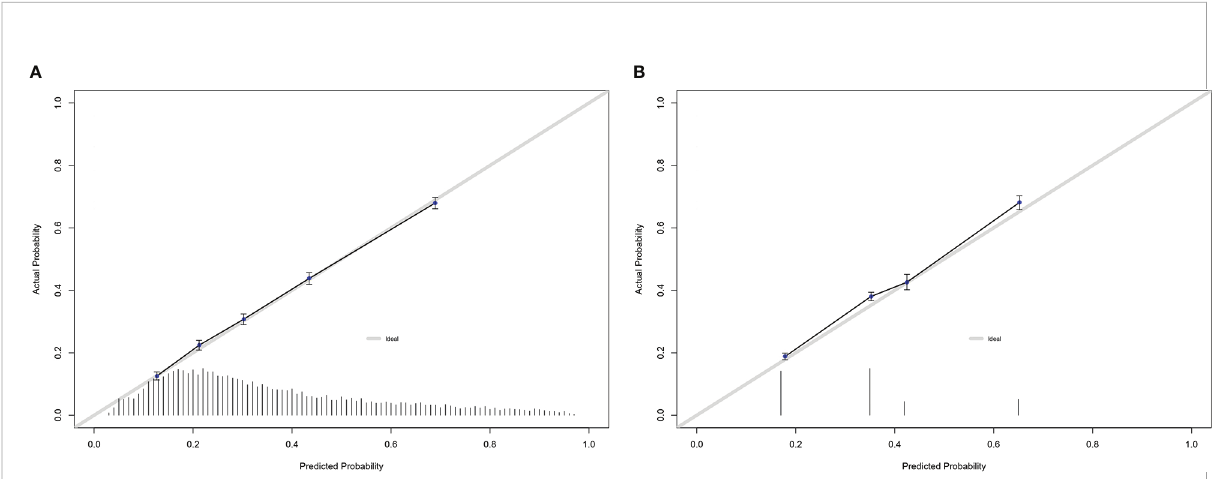
FIGURE 2 Calibration plots of observed versus predicted rates of pT3-4/pN1 within the external validation cohort of prostate cancer patients for: (A) the newly developed model; (B) NCCN risk group strati fi